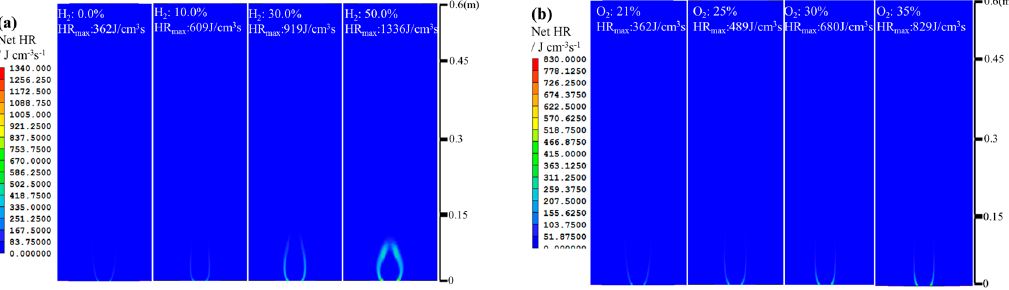
Figure 6. Effects of H 2 addition ratio ( a ) and O 2 enrichment levels ( b ) in BG-2/air flame on the distribution of the heat release rate.